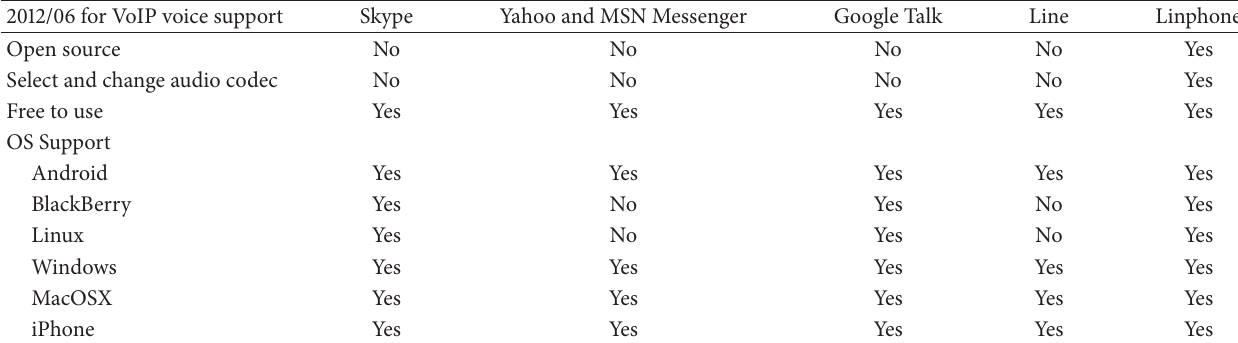
Table 1: The comparison of current VoIP software.